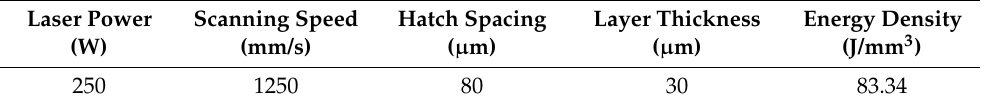
Table 1. LPBF process parameters used for the fabrication of printed specimens. Laser Power (W)